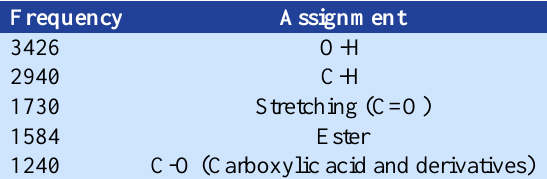
Table 4. Spectrum of gum tragacanth